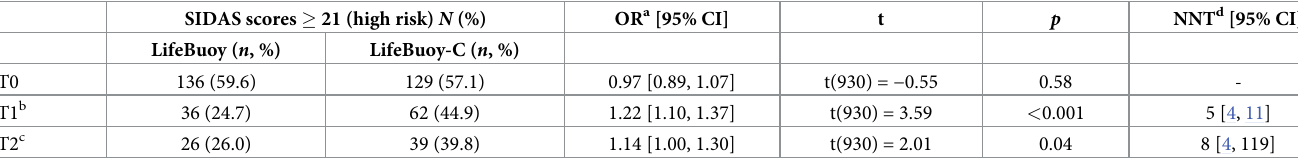
a OR reflects odds of being flagged as at risk for the LifeBuoy-C condition relative to the LifeBuoy condition. The generalized linear mixed model used to generate the ORs incorporated all participants with at least 1 data point.